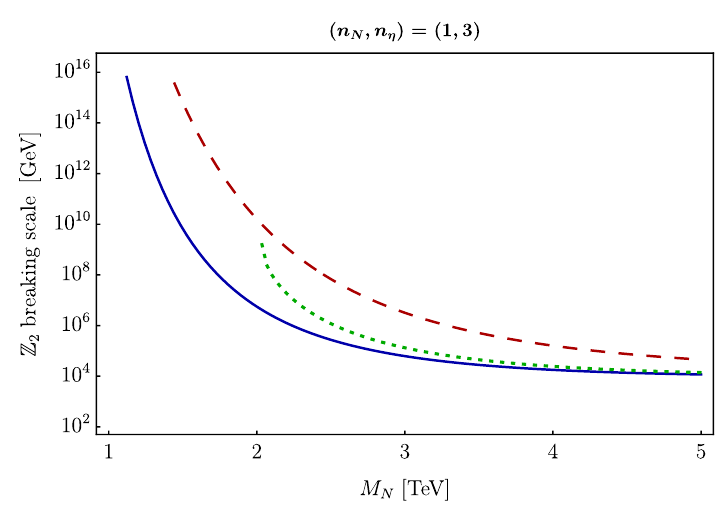
Figure 3 . Z 2 breaking scale as a function of the singlet fermion mass M N in the (1 ; 3) Scotogenic model for three di(cid:11)erent scenarios: (cid:21) aaaa